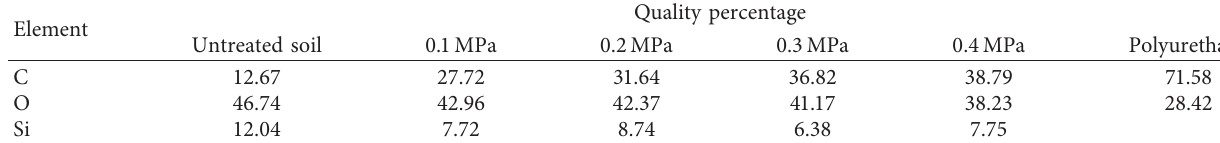
Table 3: Sample element composition.